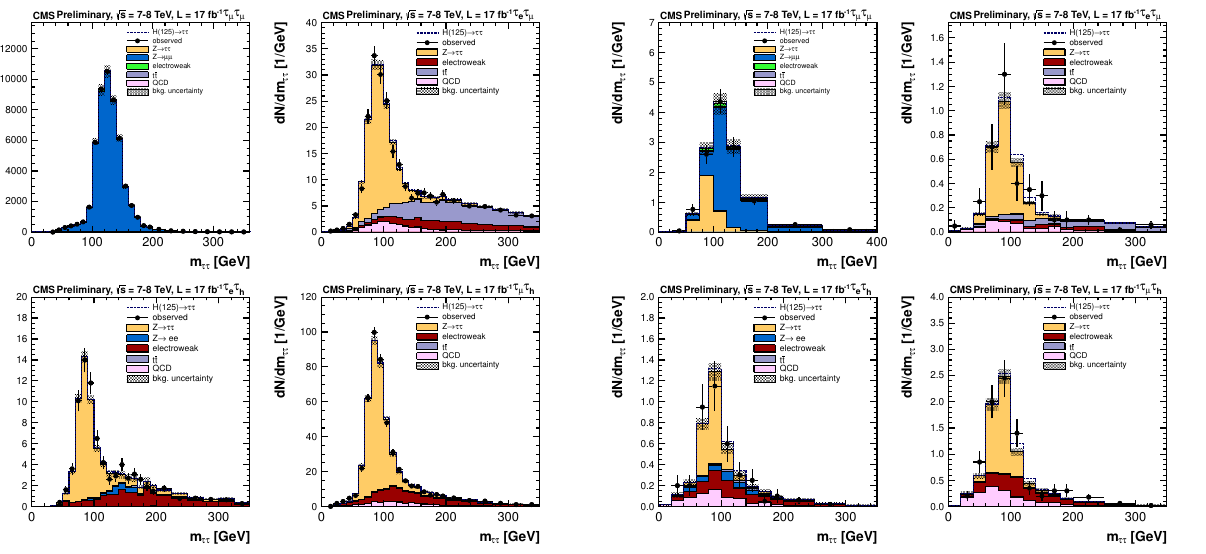
Also shown in figure 5 are the (lower left) the ob- served limit together with the unbiased expectation for a SM Higgs boson with a mass of 125 GeV. The expectation is shown by the red line. The shaded bands correspond to the one and two σ uncertainty on the expectation. This expectation and the uncertainties have been obtained from 5000 independent toy experiments based on the Asimov dataset for a SM Higgs boson with signal strength one and a mass of 125 GeV at each mass point. The interpretation of this figure should take into account that the expectation is unbiased, i.e. the nuisance parameters in the modified asymptotic CL S method have not been fitted to the data, but to the corresponding pseudo-dataset for each toy. The expectation has been obtained from the median and the uncertainties from the corresponding quantiles of the cor- responding toy